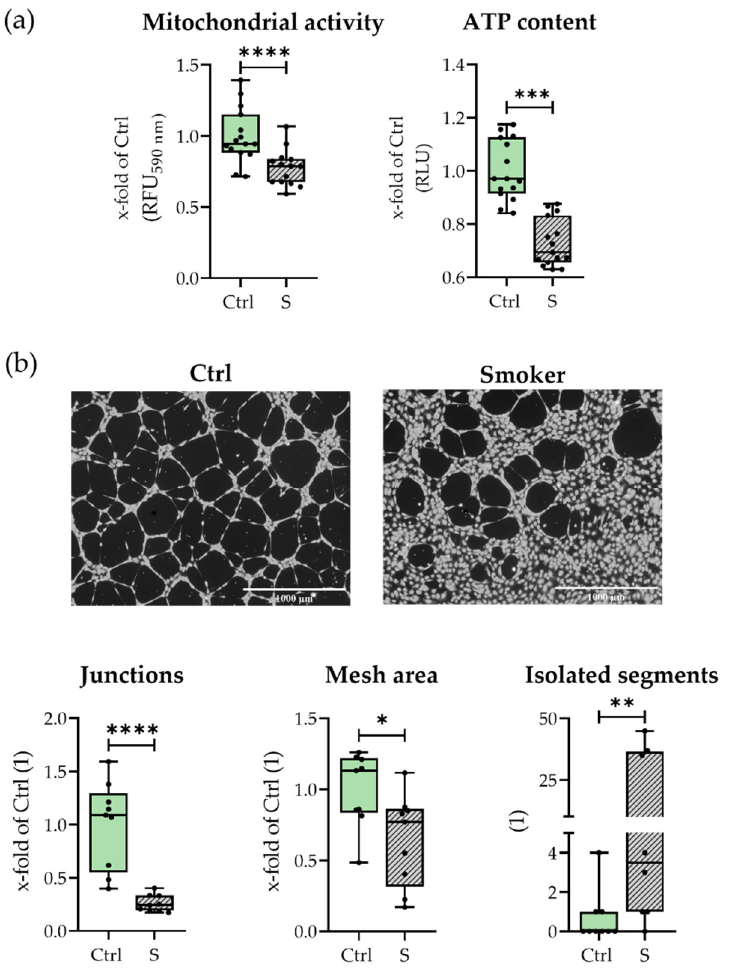
Figure 6. Effect of smokers’ (S) and non-smokers’ (Ctrl) culture supernatant on HUVEC cells. With ( a ) Effect on HUVEC proliferation measured by mitochondrial activity and ATP content in N = 5, n = 3. Both showed as x-fold of Ctrl; ( b ) Effect on HUVEC tube formation with representative life staining of formed tubes and number of junctions (as x-fold of Ctrl), Mesh area (as x-fold of Ctrl), and number of isolated segments. Shown images were recorded in 4× magnification. Scales bars indicate 1000 µm length. N = 3, n = 3. * p < 0.05, ** p < 0.01 ** p < 0.001,**** p < 0.0001.